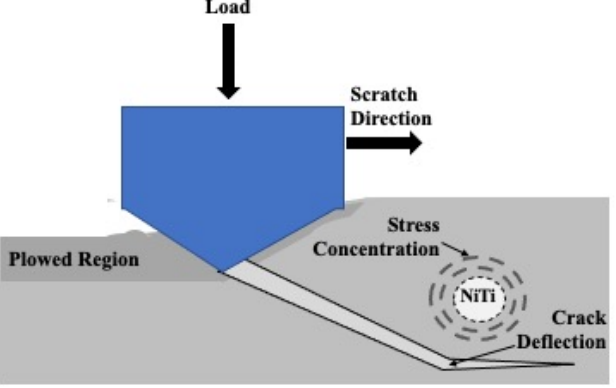
Figure 31. Representative Illustration of the Crack Around Particle Mechanism During Sliding Wear.